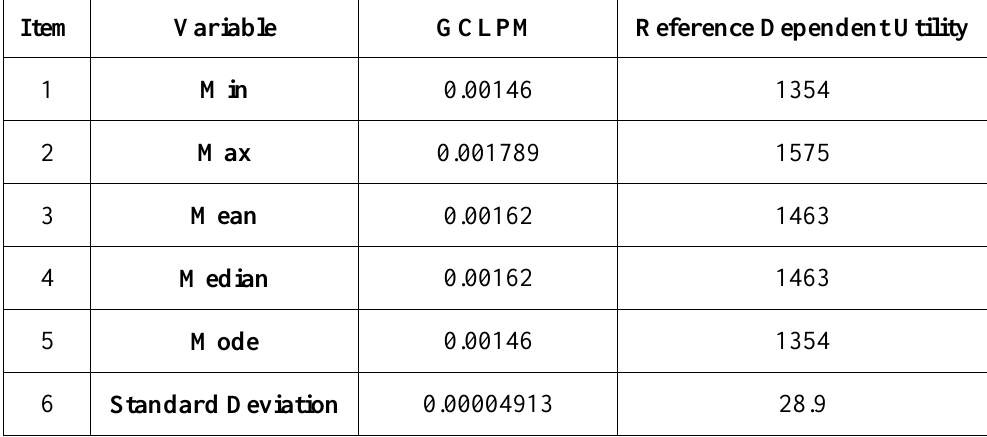
Table 10. Result Specification of Scenario 3 in Second